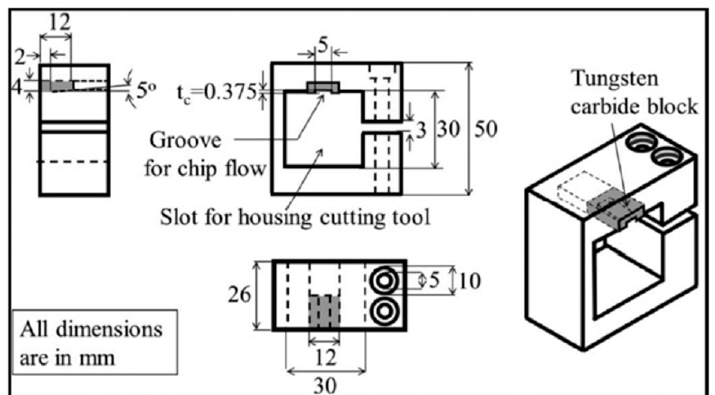
Figure 5. LSEM fixture dimensions [22].